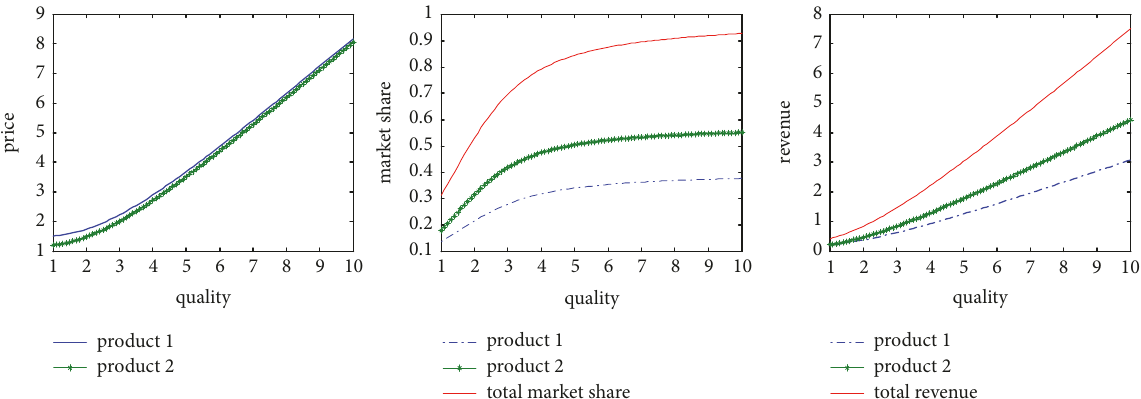
Figure 6: The influence of the quality of product on the optimal solutions.